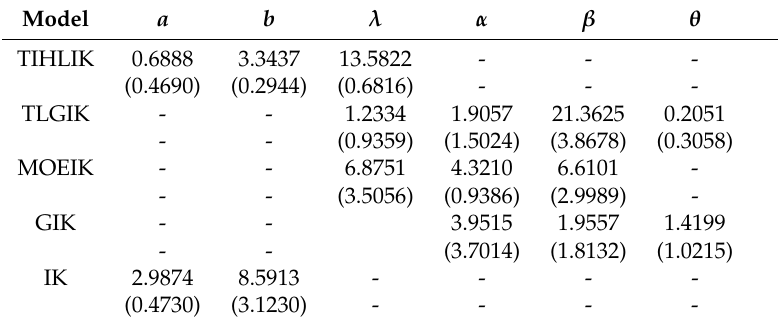
Figure 10. TTT plot and boxplot for data set 2. Table 7. MLEs along with their standard errors (in parentheses) for data set 1.